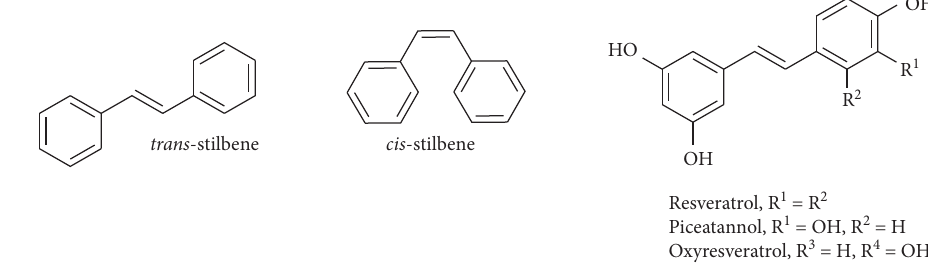
Figure 1: Chemical structures of some stilbenes.